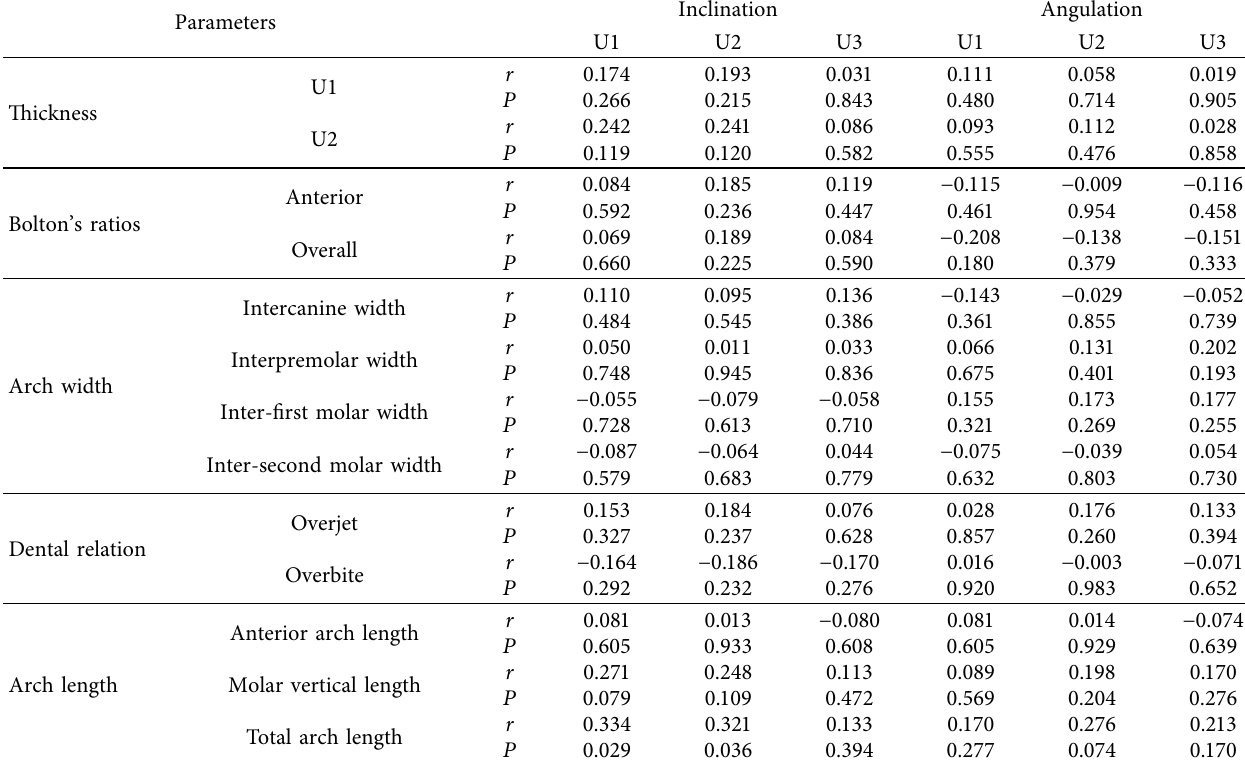
Table 2: The correlation among different